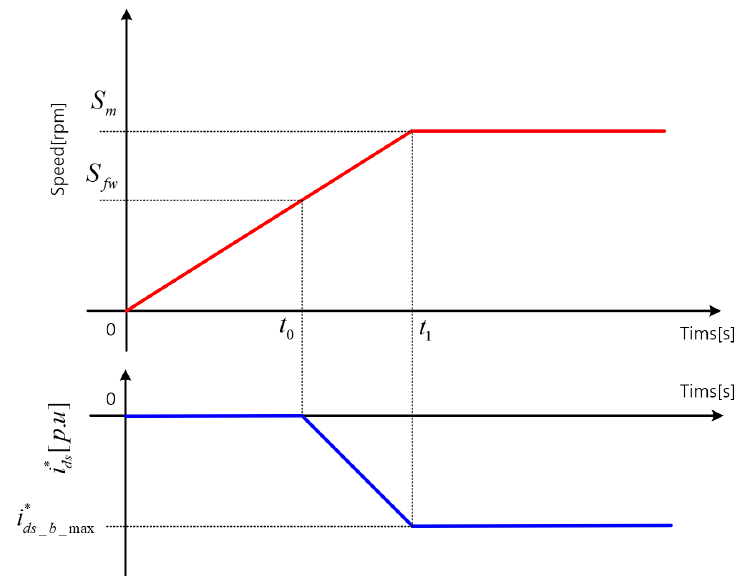
Figure 4. Ideal graphs of speed and 𝑖 (cid:3031)(cid:3046)∗ for the design of variable incremental controllers.